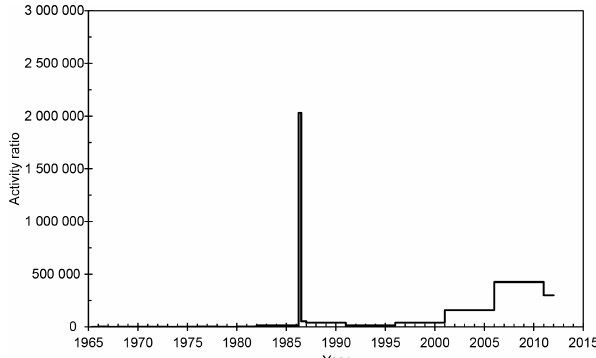
Figure 6. The ratio of total beta activity (Salminen-Paatero et al., 2019) and 239 + 240 Pu activity content in the surface air in Rovaniemi in 1965–2011. 239 + 240 Pu values below the detection limit have been replaced with half the MDA values (Table